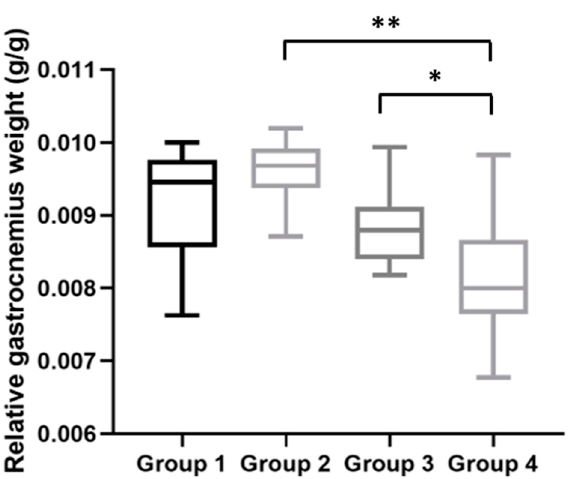
Figure 7. Relative gastrocnemius weights at the time of sacrifice. HPV + mice with DMBA (Group 4) presented a lower relative gastrocnemius weight than matched HPV − mice (Group 2) (** p < 0.01). There also was a statistically significant difference between the HPV + groups (Group 4 versus Group 3: * p < 0.05). Group 1: HPV − without DMBA application ( n = 10); Group 2: HPV − with DMBA application ( n = 10); Group 3: HPV + without DMBA application ( n = 10); Group 4: HPV + with DMBA application ( n = 10).